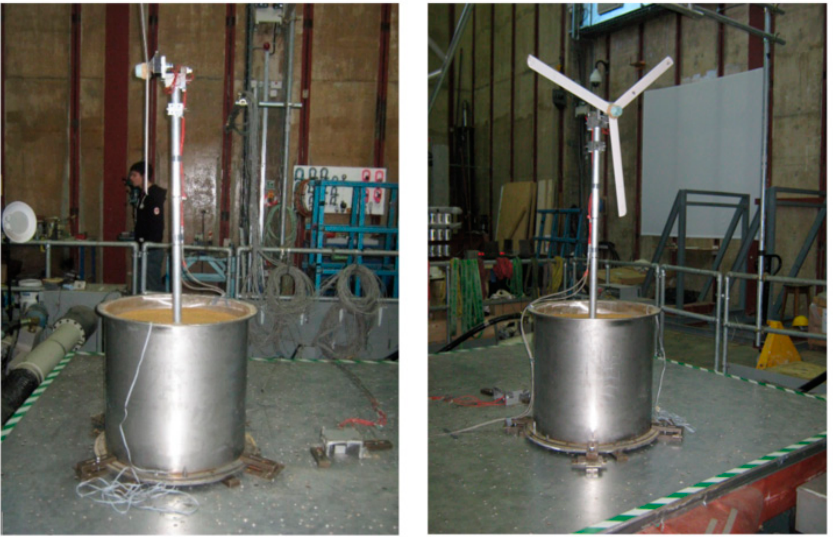
Figure 29. Illustration of the model wind turbine positioned on the BLADE shaking table.